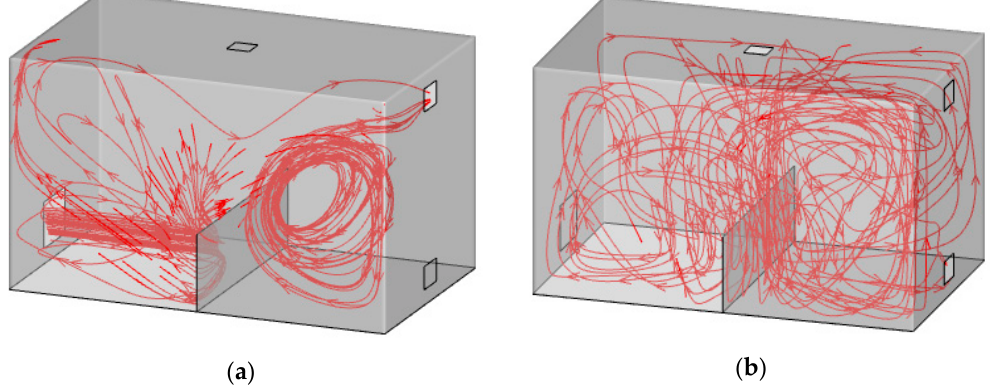
Figure 8. Streamlines under two ventilation patterns in Model I: ( a ) Down-supply up-return; ( b ) top-supply down-return.